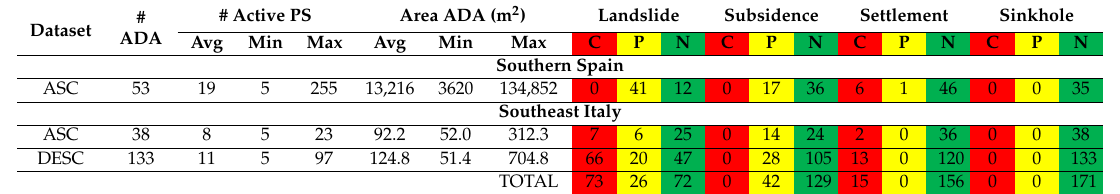
Table 2. Summary of ADA extracted with QI < 3 and classified in the test